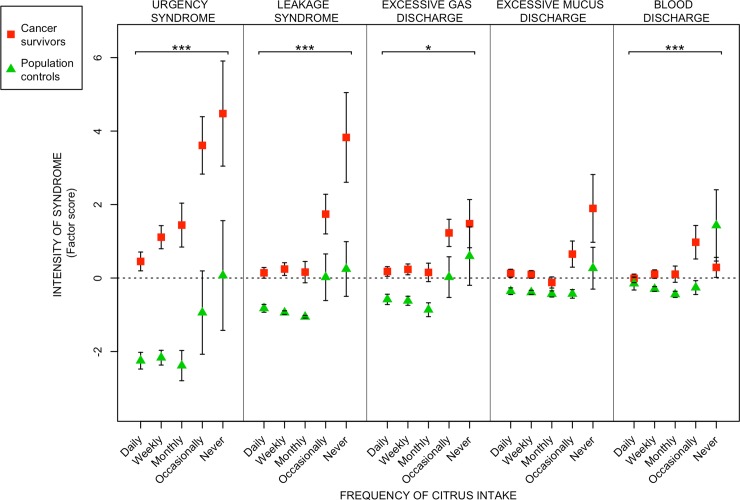
Relationships between radiation-induced survivorship syndromes and frequency of citrus intake.The figure depicts the relationships between frequency of citrus intake (x-axis) and intensities (factor scores) of the five radiation induced syndromes (y-axis: defecation-urgency syndrome, fecal-leakage syndrome, excessive gas discharge, excessive mucus discharge and blood discharge) among long-term gynecological cancer survivors and population controls. Red squares and green triangles denote the mean syndrome intensities within certain citrus intake frequency levels. Vertical black lines stretch between plus-minus the standard error of the mean. Asterisks correspond to significance levels of the Spearman correlations between syndrome intensities and frequency of citrus intake according to: p ≤ 0.001 - ***, 0.001 < p ≤ 0.01 - **. 0.01 < p ≤ 0.05 - *. Estimates of the Spearman correlations are found in Tables 2 and 3.